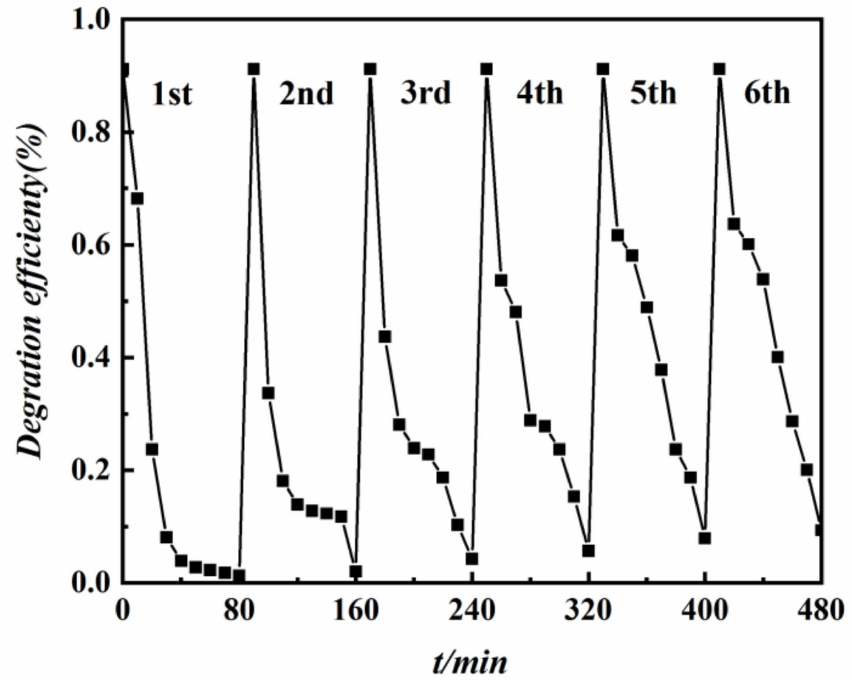
Figure 12. Regeneration and reusability of the photocatalyst in different